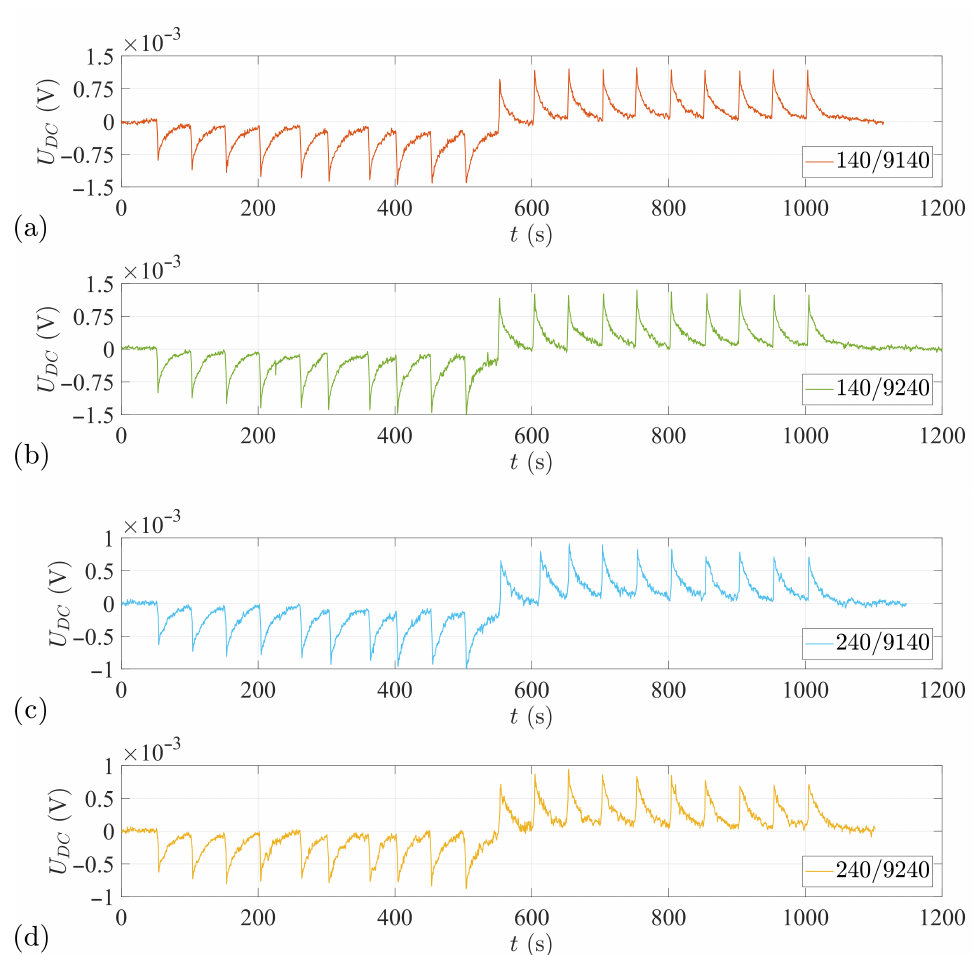
Figure 15. System response to supply voltage spikes for: ( a ) 140/9140; ( b ) 140/9240; ( c ) 240/9140; and ( d ) 240/9240 transistor